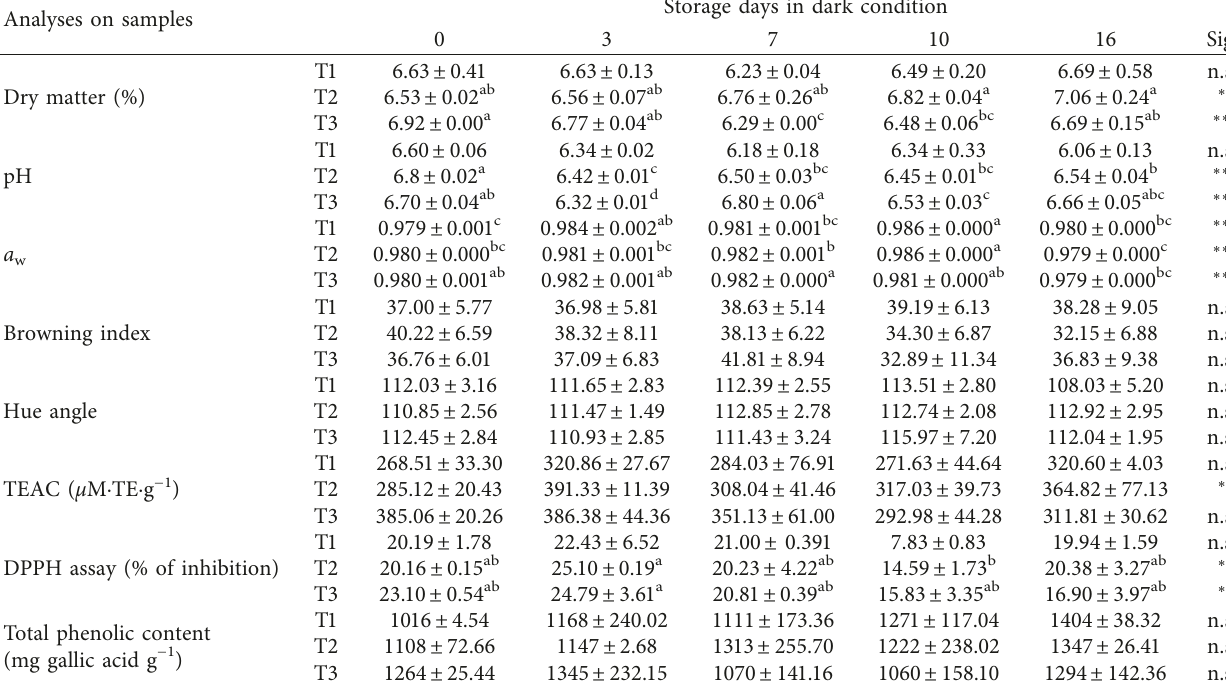
Table 2: Physicochemical parameters of pretreated leaves of Valeriana stored in dark condition. Analyses on